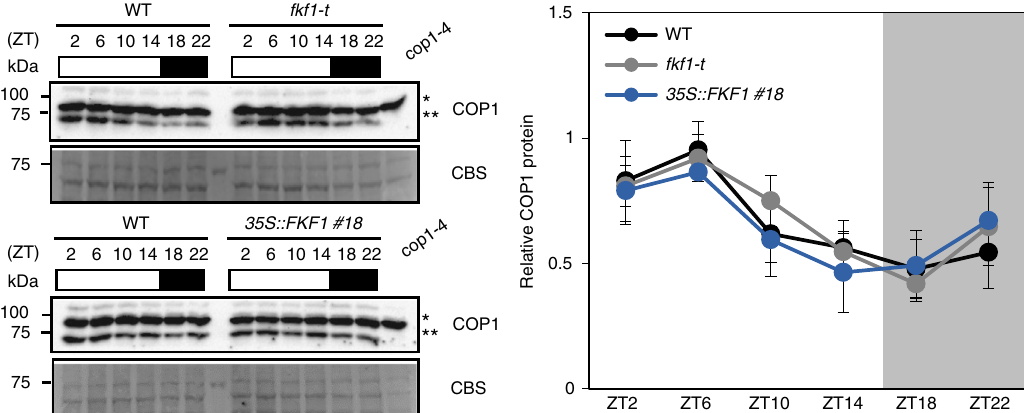
Fig. 3 The FKF1 – COP1 interaction does not affect COP1 stability. The diurnal patterns of COP1 levels are shown in wild type (Col-0), fkf1-t , and 35S::FKF1 #18 under LD. The 10-day-old seedlings were harvested every 4 h over the course of a day. Total protein (70 μ g) extracted from each sample was immunoblotted to measure the COP1 levels using an anti-COP1 polyclonal antibody. The intensity of each COP1 band (**, lower band) was normalized to the non-speci fi c band (*, upper band) in each lane. Quantitative COP1 data were exported from ImageJ (https://imagej.nih.gov/ij/index.html). Data are means ± s. d. from fi ve immunoblot replicates